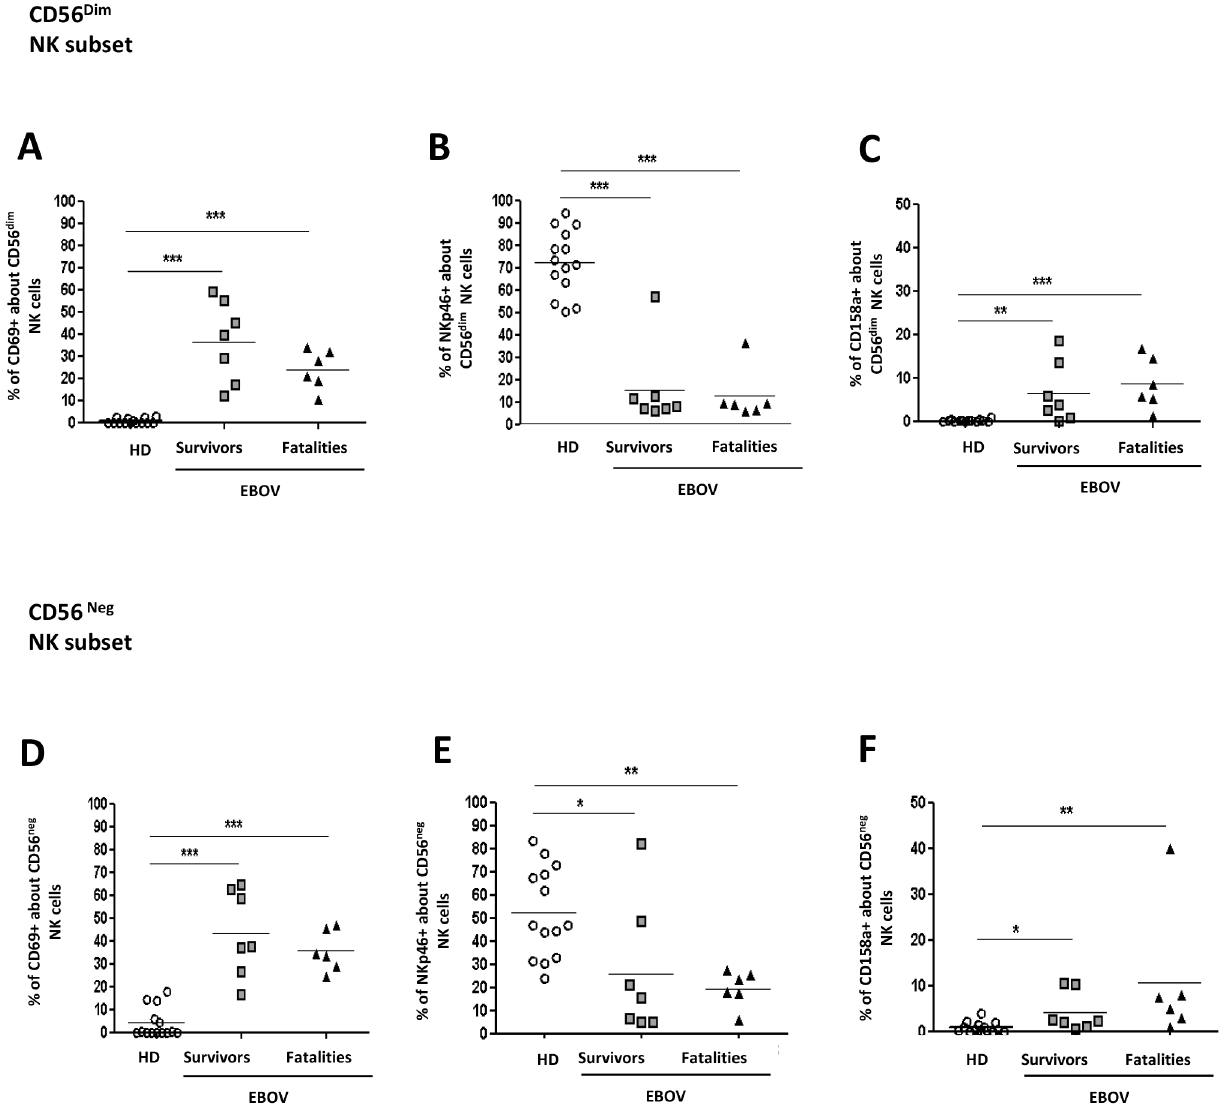
Fig 3. NK cells phenotype in survivors and in fatalities. The frequencyof CD56 dim NK cells expressingCD69 pos (A), NKp46 pos (B) and CD158a pos (C) was analyzedin HD (n = 14), EBOV-survivors (n = 8) and EBOV-fatalities (n = 6). The frequency of CD56 neg NK cells expressing CD69 pos (D), NKp46 pos (E) and CD158a pos (F) was analyzedin HD (n = 14), EBOV-survivors (n = 8) and EBOV-fatalities (n = 6). Statistical analysiswas performed by using Mann Whitney test and differences were considered significantwith a p < 0.05,and highlightedwith an asterisk.. * : p < 0.05; ** : p < 0.01; *** : p <